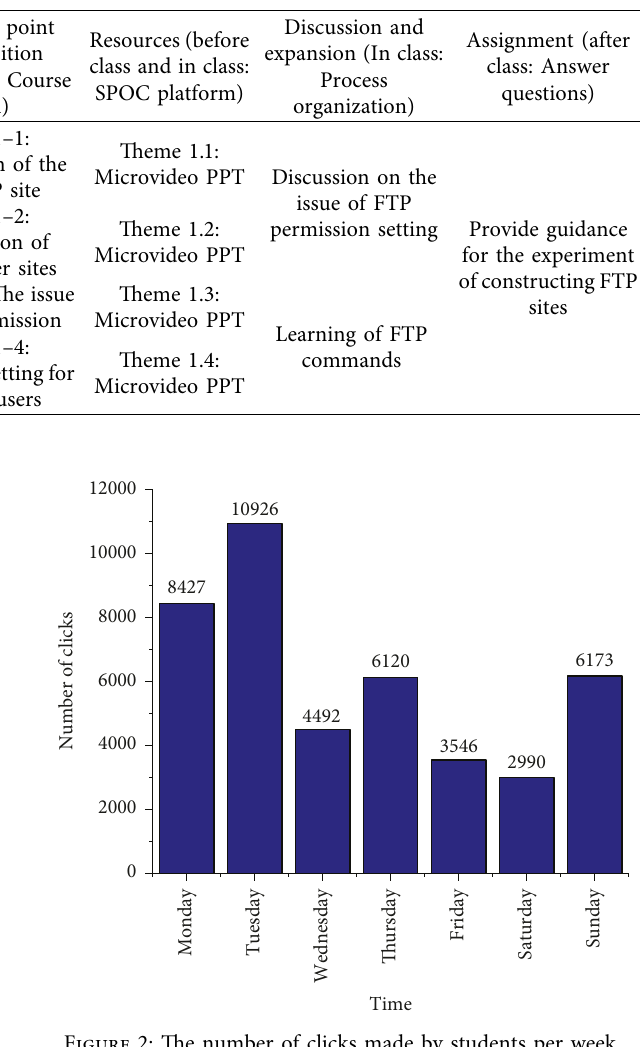
Table 2: The knowledge point decomposition and content design of the course themes.